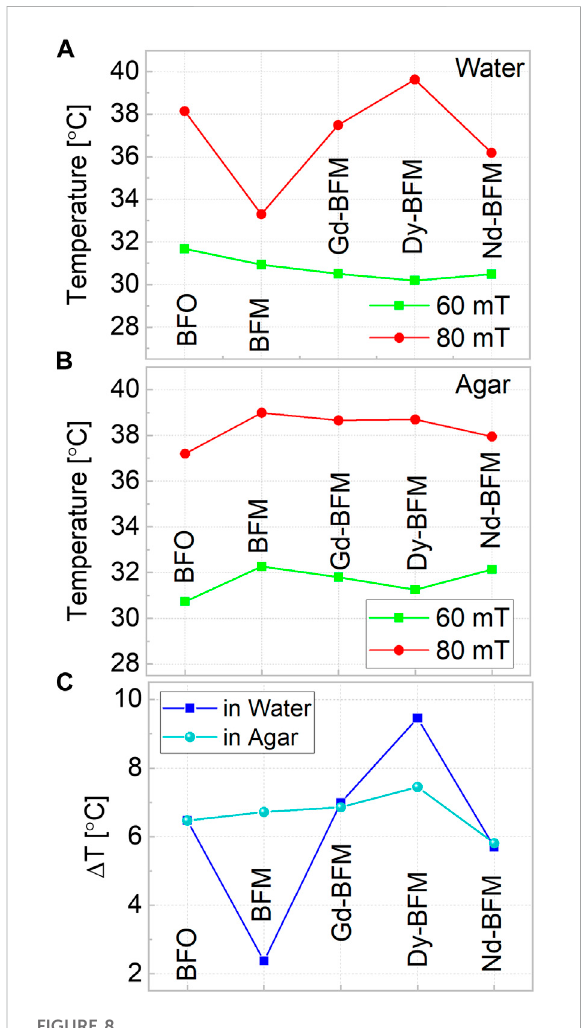
FIGURE 8 Hyperthermia tests at two different fi elds 60 mT and 80 mT ofalldopedandundopedBFONPs,inwater (A) ,andinagar (B) and (C) shows the comparison of temperature difference in both mediums at 3 mg/ml concentrations.